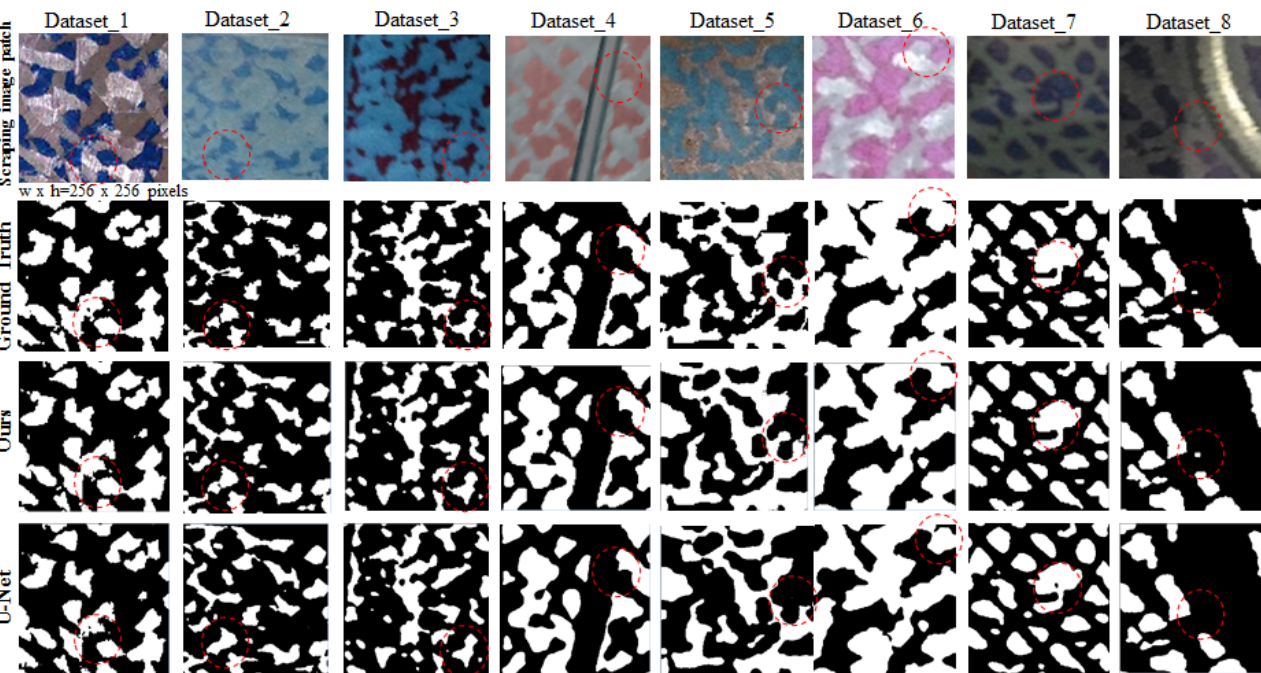
Figure 12. Comparison of prediction results between U-Net and our model on the eight different types of scraping images. The first row and second row are eight different types of scraping image patches and the pixel-wise ground truth that corresponds to the patch, respectively. The third row and fourth row are the prediction result predicted by our model and U-Net, respectively.